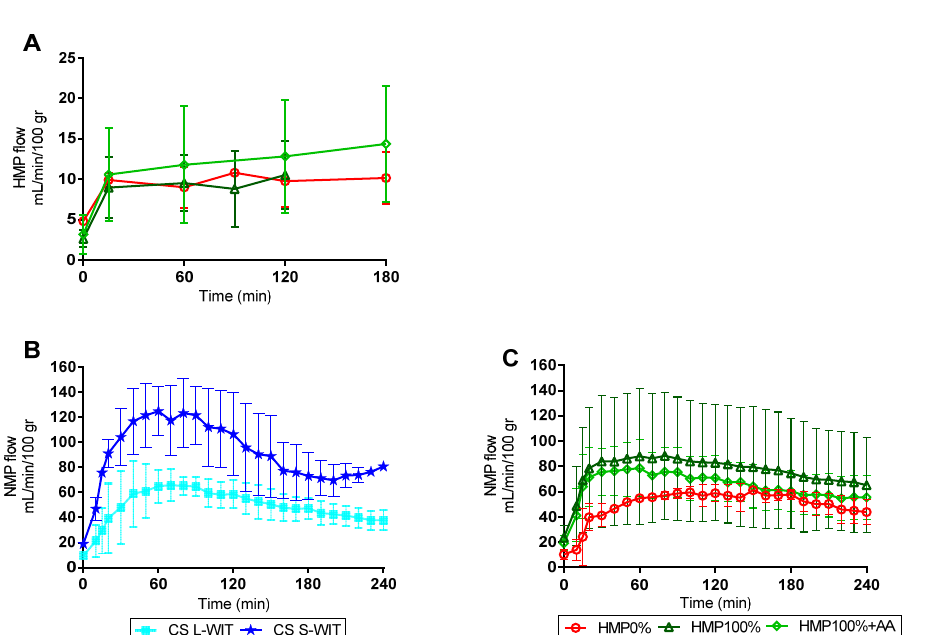
Figure 3. Renal flow rates during hypothermic and normothermic kidney perfusion. Porcine kidneys preserved by CS or HMP for 3 h and subsequently perfused for 4 h with a blood-based perfusion solution to test kidney function. ( A ) Renal flow rates during HMP, ( B ) Renal flow rates during NKP of CS preserved kidneys. ( C ) Renal flow rates during NKP of HMP preserved kidneys. CS, cold storage; HMP, hypothermic machine perfusion; NKP, normothermic kidney perfusion. The data are shown as mean ± SD.